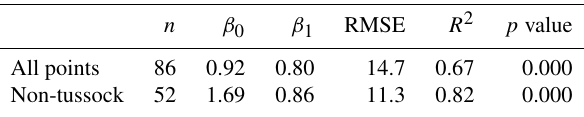
Table 4. Parameters of weighted regression between reference and RPAS-derived snow